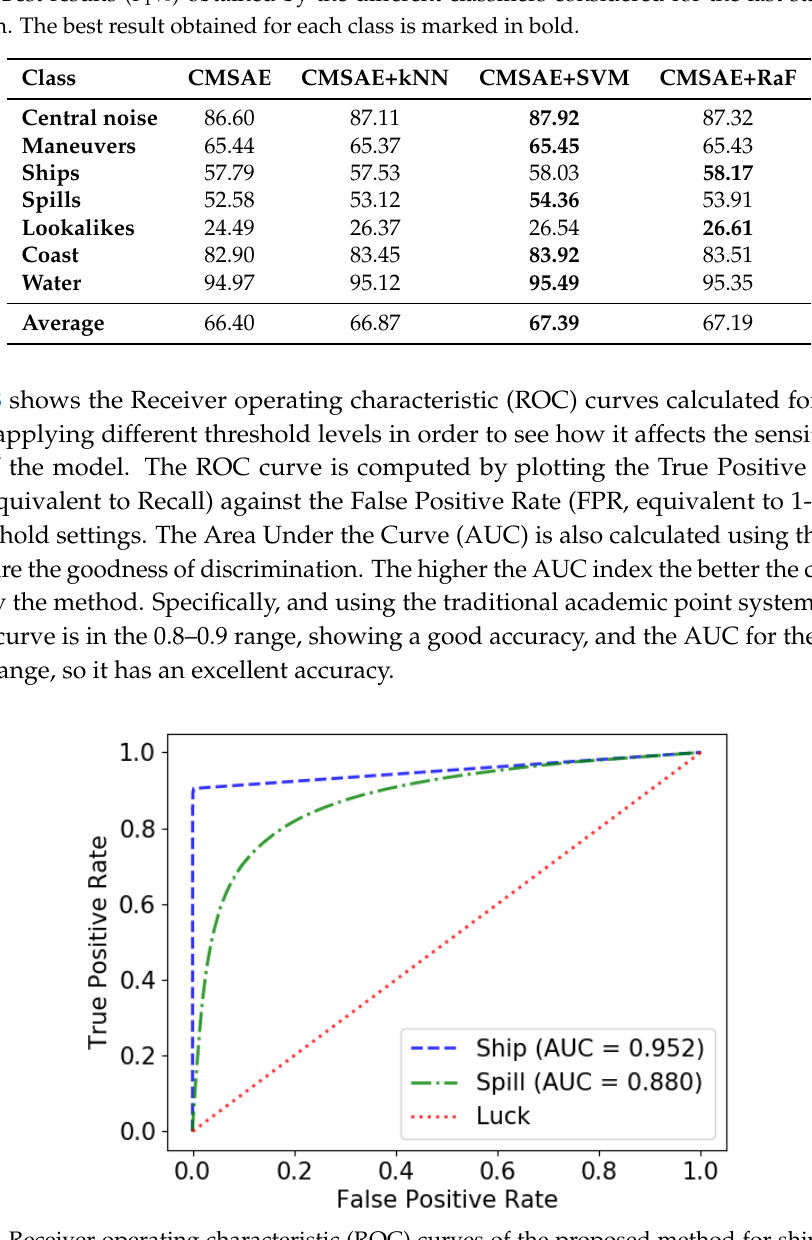
Figure 8. Receiver operating characteristic (ROC) curves of the proposed method for ships and oil spills